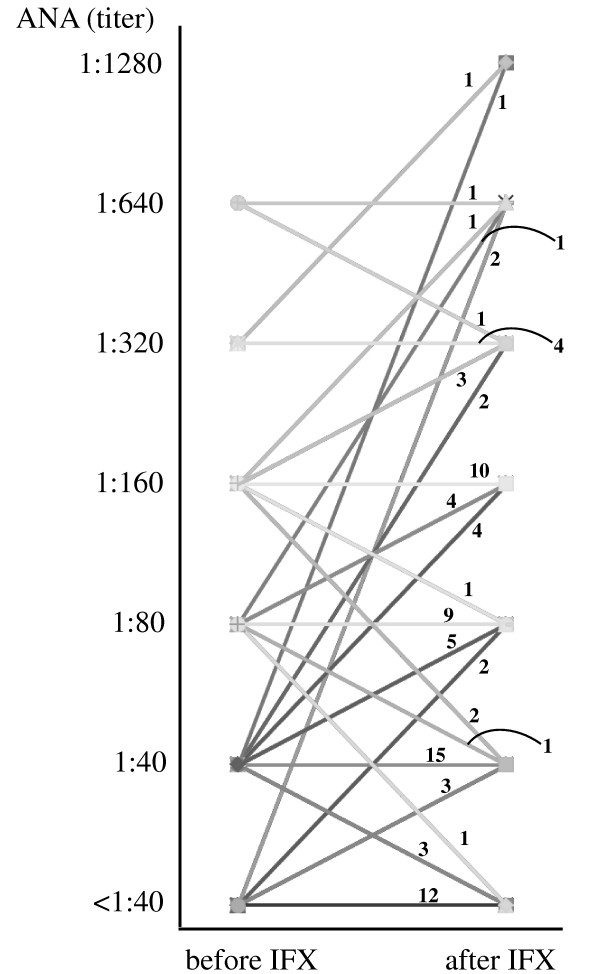
Changes of ANA titer between before and after IFX. The numbers in the graph indicate the numbers of patients. IFX, infliximab; ANAs, antinuclear antibodies.